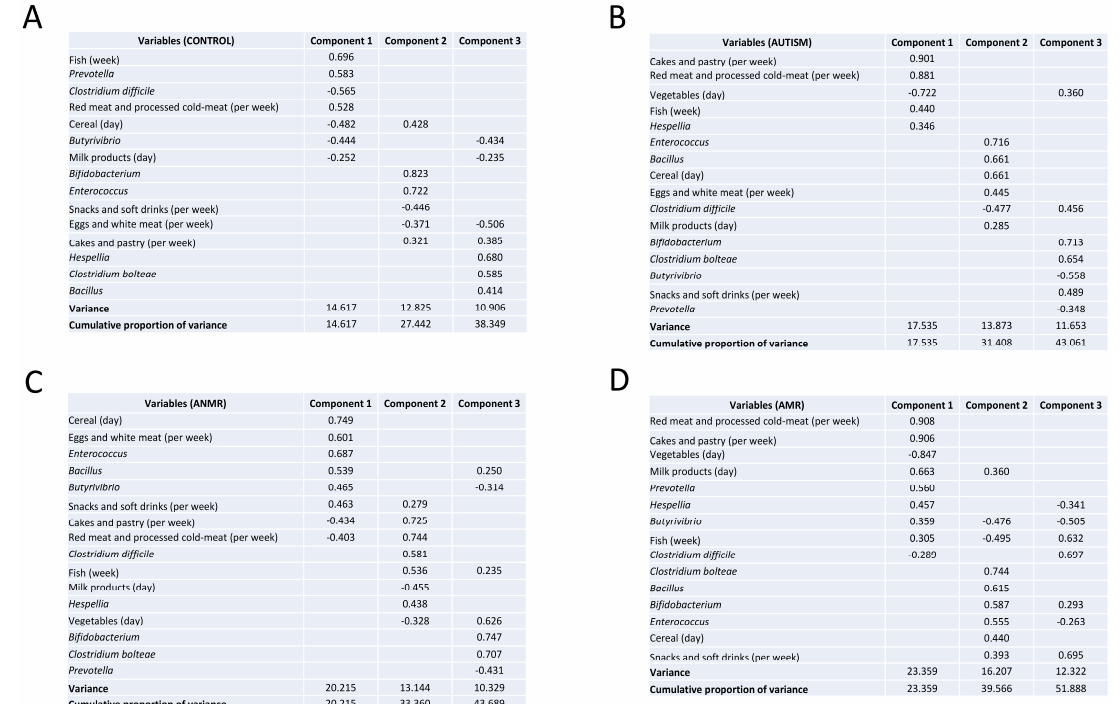
Figure 3. Principal component analysis between intestinal microbiota and food consumption in children with ASD and healthy children. Extraction of the initial set of uncorrelated components was accomplished with the principal factor method and then the orthogonal rotation of components was used to facilitate interpretation. Factor loading was used to interpret the factor structure. Loadings are equivalent to Pearson correlation coefficients, and a higher loading indicates a stronger relation between a factor and an observed variable. Strong loading was defined as a value ≥ 0.6; moderate as 0.4–0.59 and low as <0.4. ( A ) Control group, ( B ) Children with ASD, ( C ) Children with ANMR, ( D ) Children with AMR. ASD, children with autism spectrum disorders; AMR, children with autism mental regression; ANMR, children with autism non-mental regression.